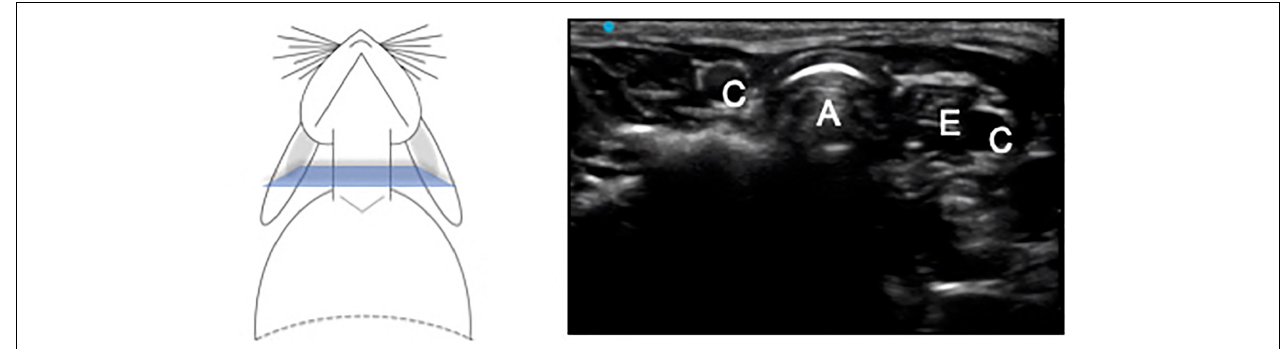
FIGURE 1 | Transverse plane of the trachea at the middle cervical level. A – Trachea, C – Carotid artery, E – Esophagus.